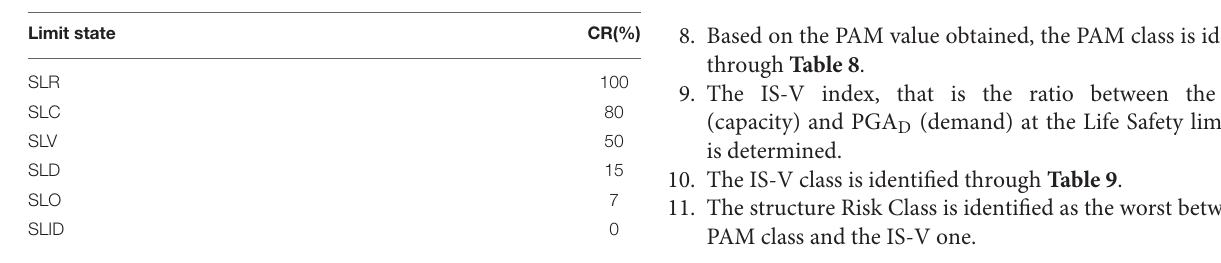
TABLE 10 | Reconstruction cost percentage value associated to each Limit State.